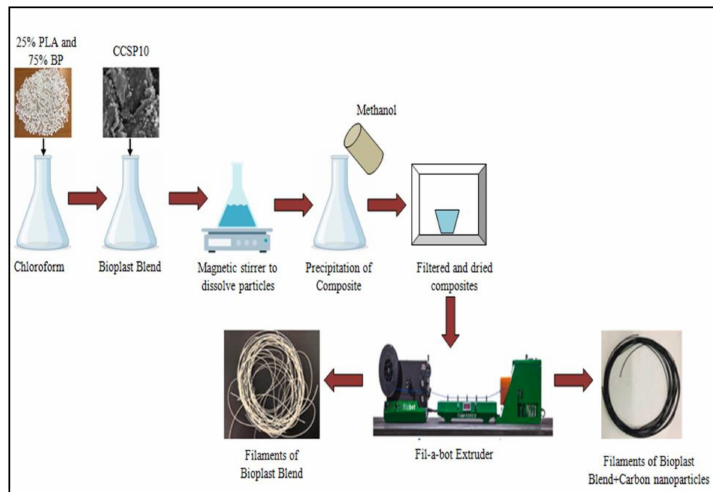
Figure 12. Synthetic procedure for nanocomposites.